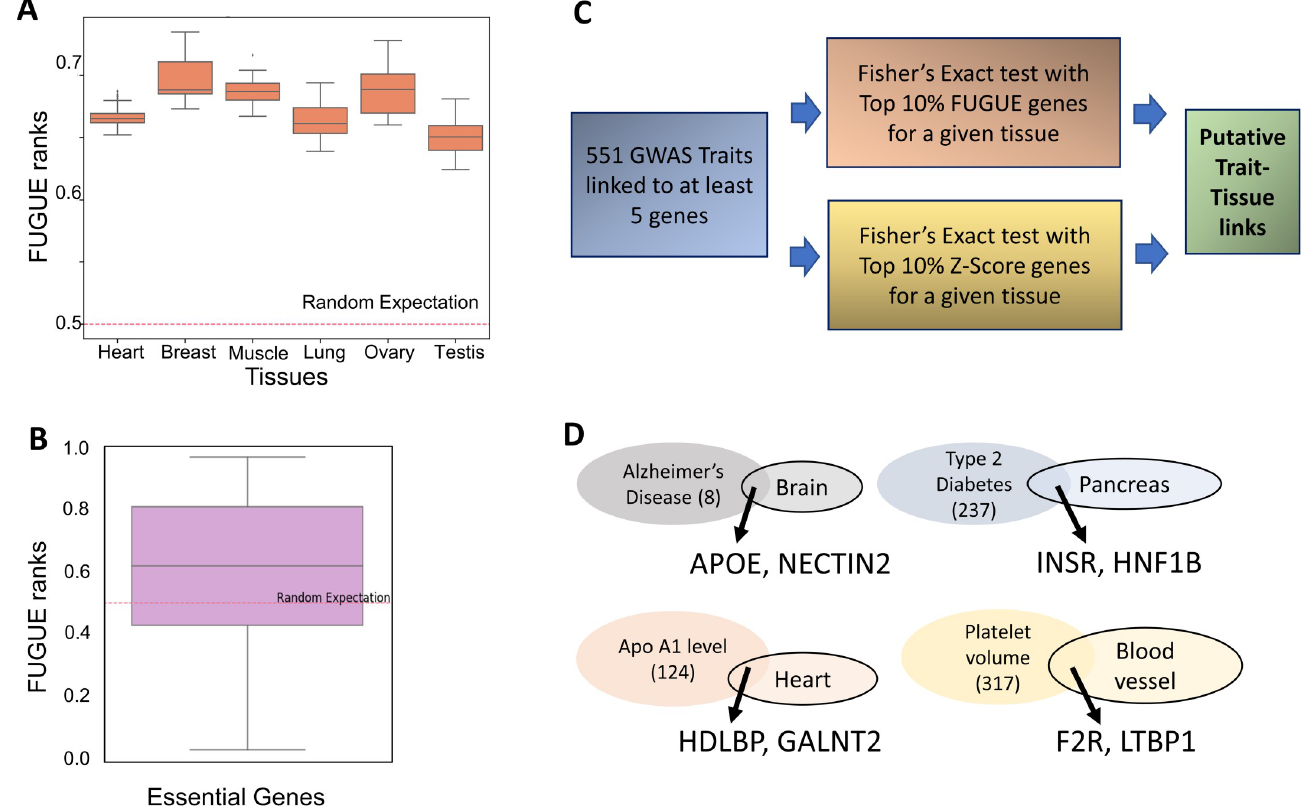
Fig 3. FUGUE validation and application to trait-tissue mapping. (A) In 6 tissues where the trait is unambiguously mapped to the tissue based on mouse knockout, the tissue-relevant genes are ranked significantly higher (y-axis) than the random expectation. (B) Essential genes in human iPSCs are ranked much higher than random expectation; here the model was trained on GTEx and applied to iPSC, minimizing overfitting. (C) Pipeline to map GWAS genes to specific tissues based on the overlap of GWAS genes with the top ranked genes by FUGUE or by Z-score. (D) A few examples of trait-tissue mapping uniquely revealed by FUGUE. The trait oval indicates the number of GWAS genes, the tissue oval indicates the top 10% TRGs and a couple of top ranked genes associated to the trait are highlighted. These genes have direct literature evidence for involvement with the trait.